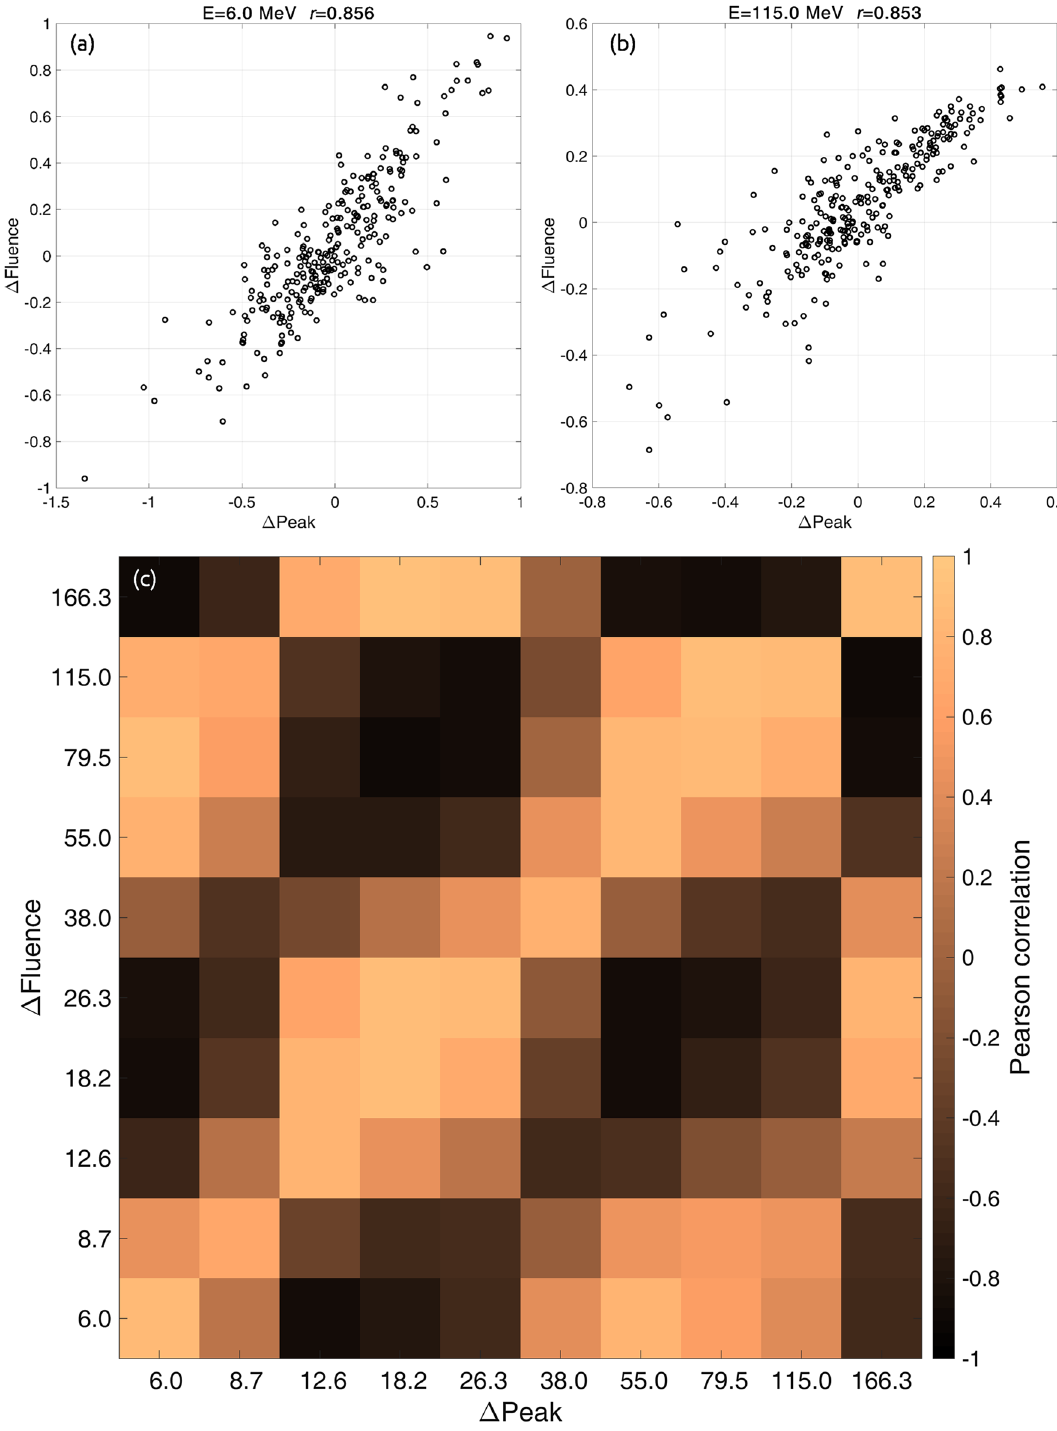
Fig. 7. (a) and (b) cross-plots of fi tting residuals of all Peak and Fluence spectra at 6 MeV and 115 MeV respectively, and (c) mapping of the correlation coef fi cients of all Peak residuals to all Fluence residuals at all